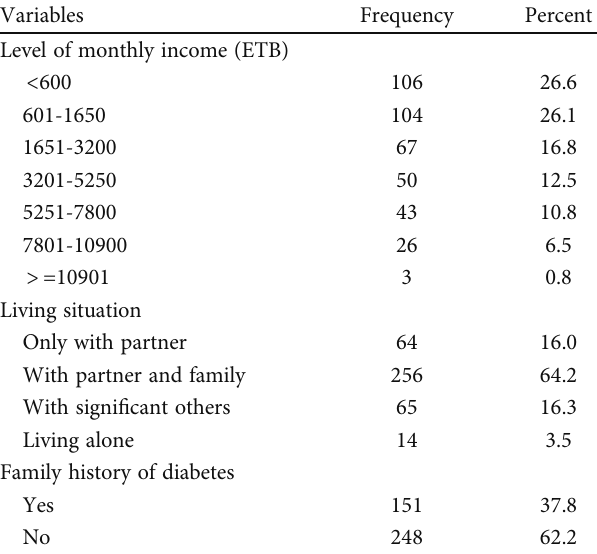
Table 2: Family-related characteristics of persons with diabetes ’ perceptions of family burden and associated factors at a university hospital ( n = 399